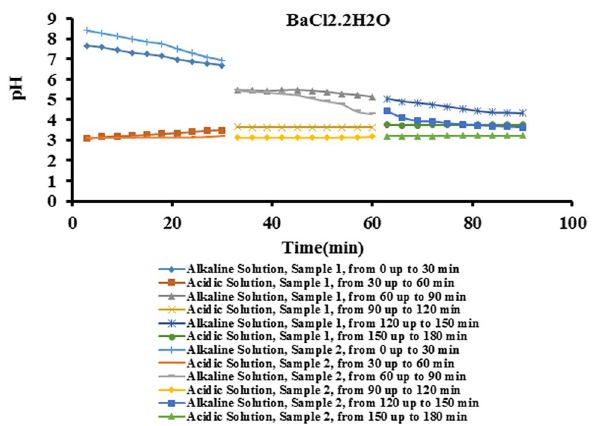
Fig. 9 pH changes in acidic and alkaline BaCl over